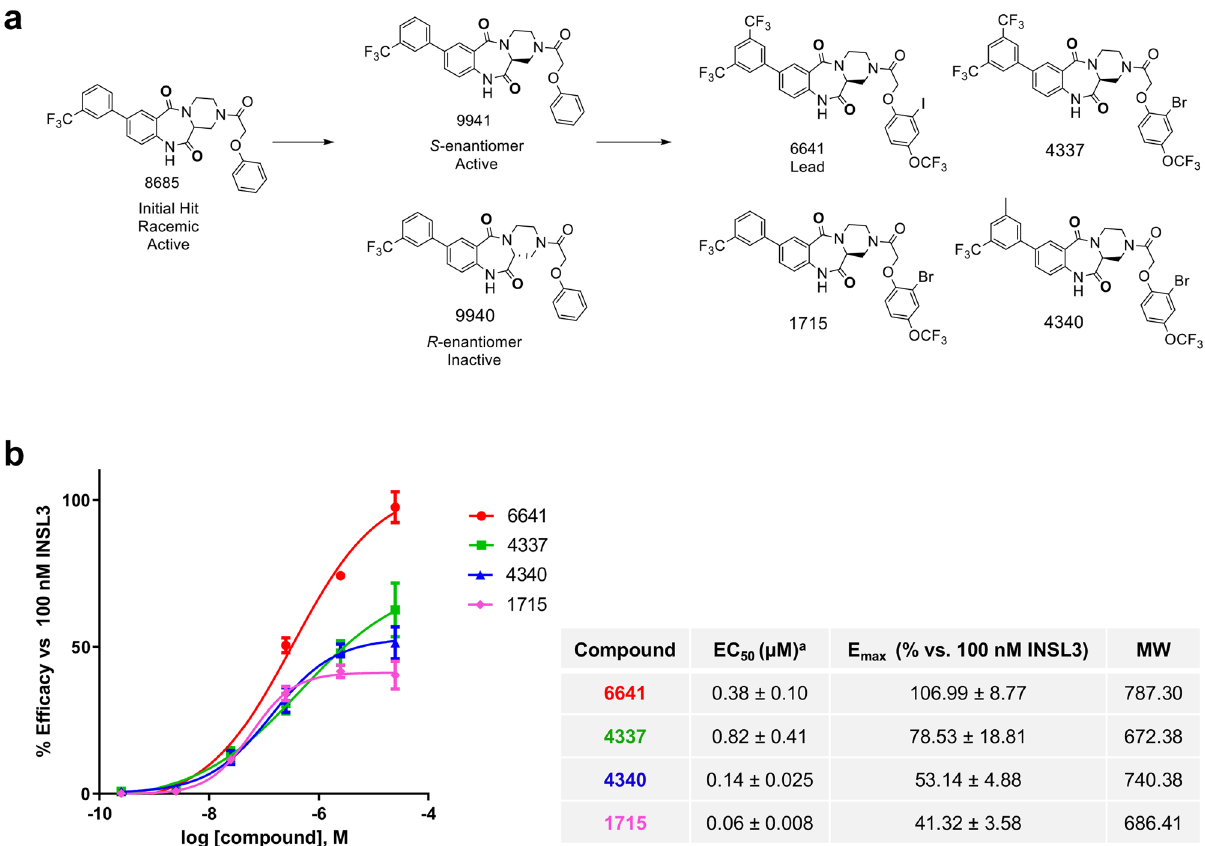
Fig. 1 RXFP2 agonist screening and SAR study. a Schematic representation of SAR study showing the initial hit and active enantiomer con fi guration that led to the fi nal 4 compounds, including the lead compound 6641. b Ranking of the RXFP2 agonist activity by HTRF cAMP assay in HEK-RXFP2 cells. The cAMP response induced by the compounds was normalized to the cAMP response induced by 100 nM INSL3 as 100% ef fi cacy and the cAMP response induced by DMSO vehicle as 0% ef fi cacy. E max and EC 50 were calculated using four parameter nonlinear fi t dose-response stimulation curves. Results are expressed as mean ± SEM of 3 independent experiments. a The EC 50 is expressed in micromolar and is the concentration necessary to reach 50% of maximum cAMP signal. Molecular weight